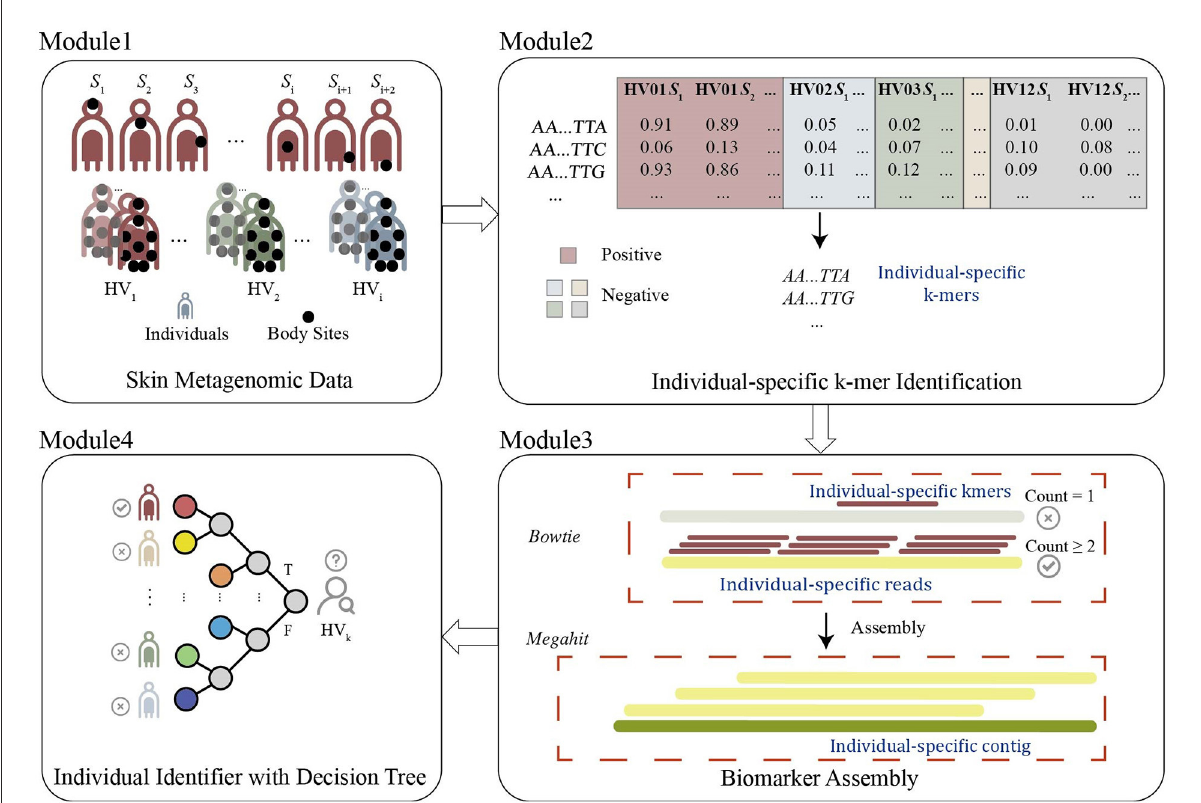
FIGURE1 The framework to detect individual-specific microbial DNA fingerprints includes four modules: Module 1-data preparation removes outliner samples, and divides the dataset into balanced training and testing sets. Module 2- individual-specific k -mers detection identifies k -mers with significantly present/absent or abundant difference. Module 3- individual-specific markers production assembles the individual-specific k -mers to contigs as individual-specific microbial DNA marks. Module 4- an individual-identifying decision tree identifies individuals with individual-specific markers.